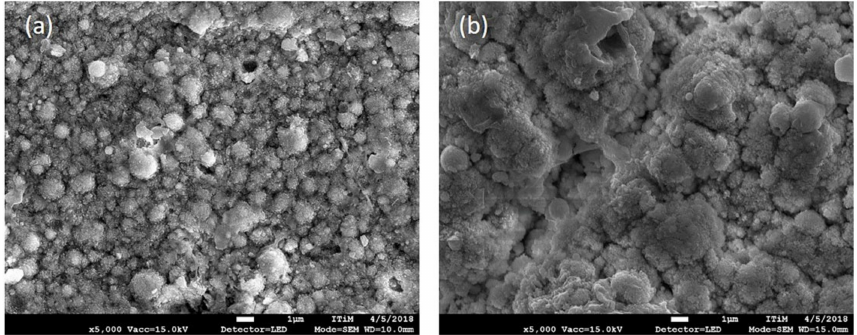
Figure 2. Top-view HR-SEM images for obtained coatings. Scale bar = 1 µ m; ( a ) Ti_10_100; ( b )